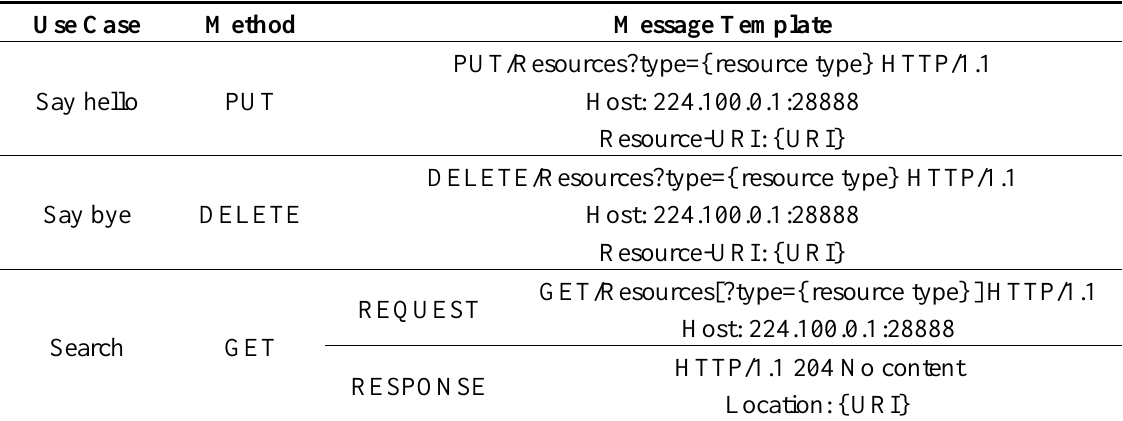
Table 1. Message templates for discovery use